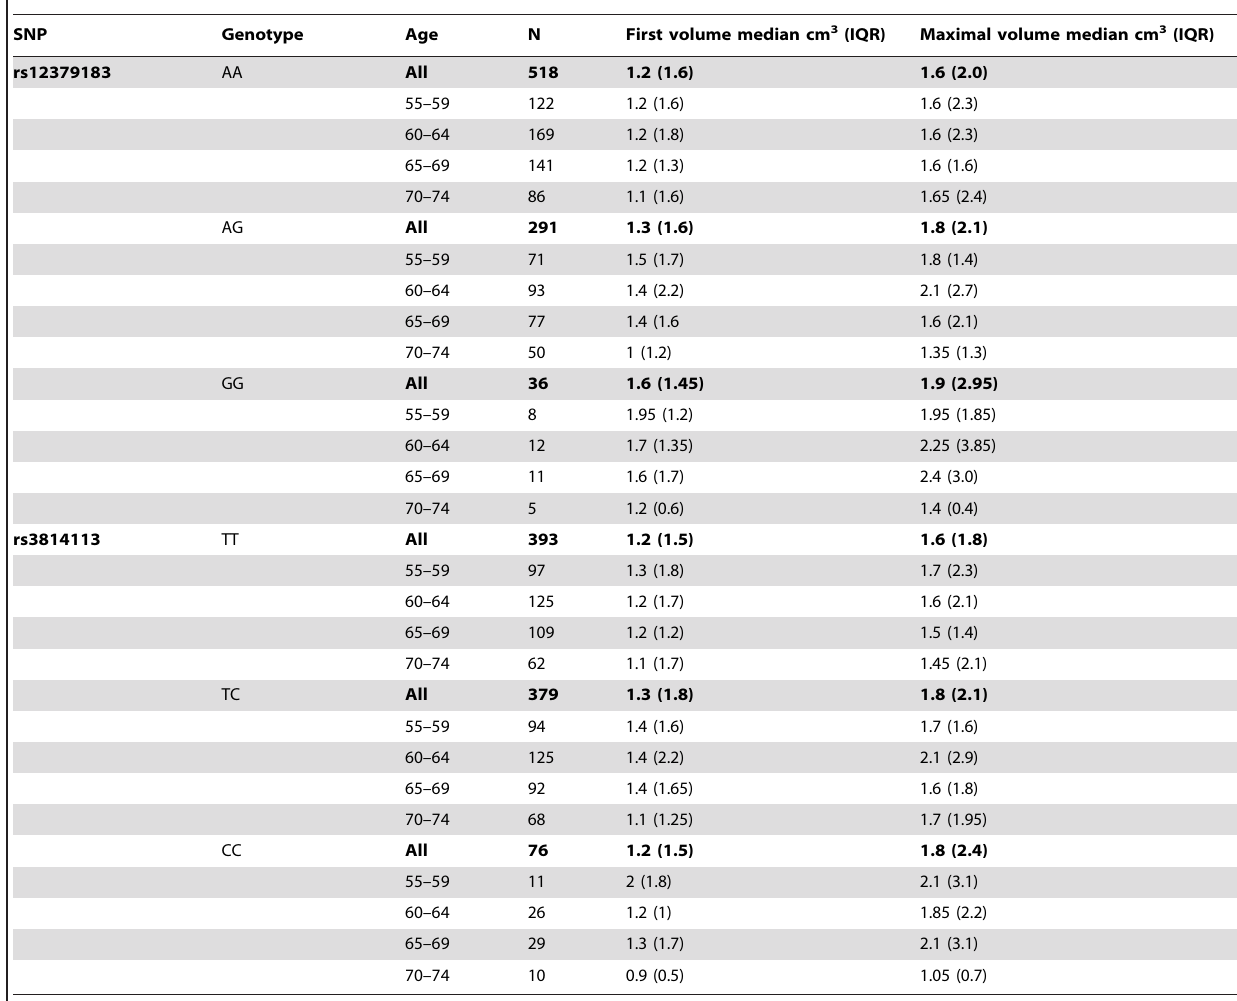
Table 4. 9p22 genotypes and ovarian